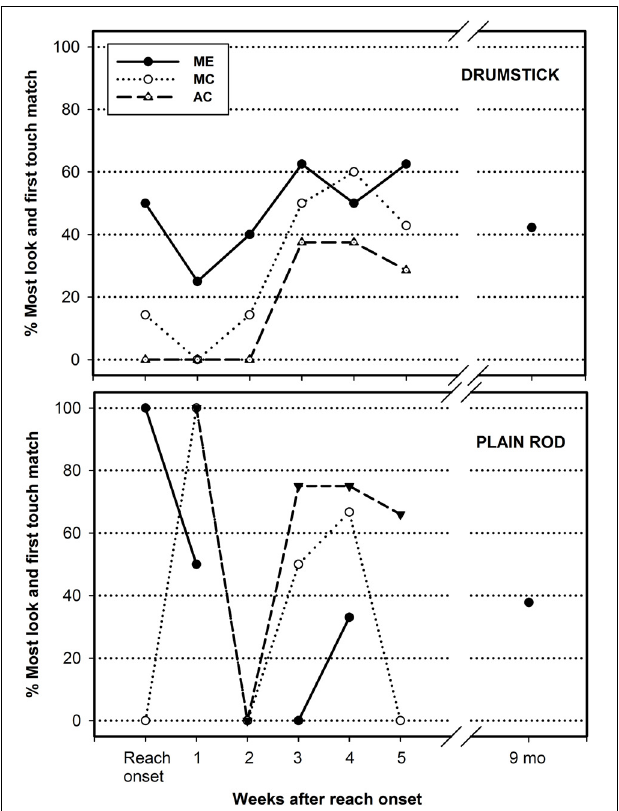
FIGURE 5 | Rate of within trial matches between the most looked object area and the first touched object area by infant, by object (drumstick top graph, plain rod bottom graph) and by week following reach onset. The corresponding results for a group of 9-month-old infants are provided for comparison